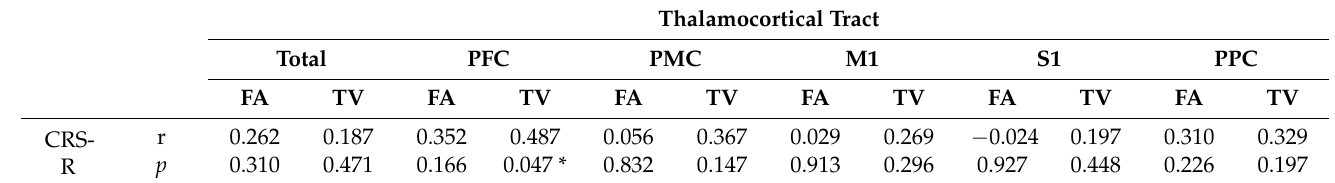
Table 2. Correlations between the score of the Coma Recovery Scale-Revised and diffusion tensor tractography parameters for the entirety and subparts of the thalamocortical tract.